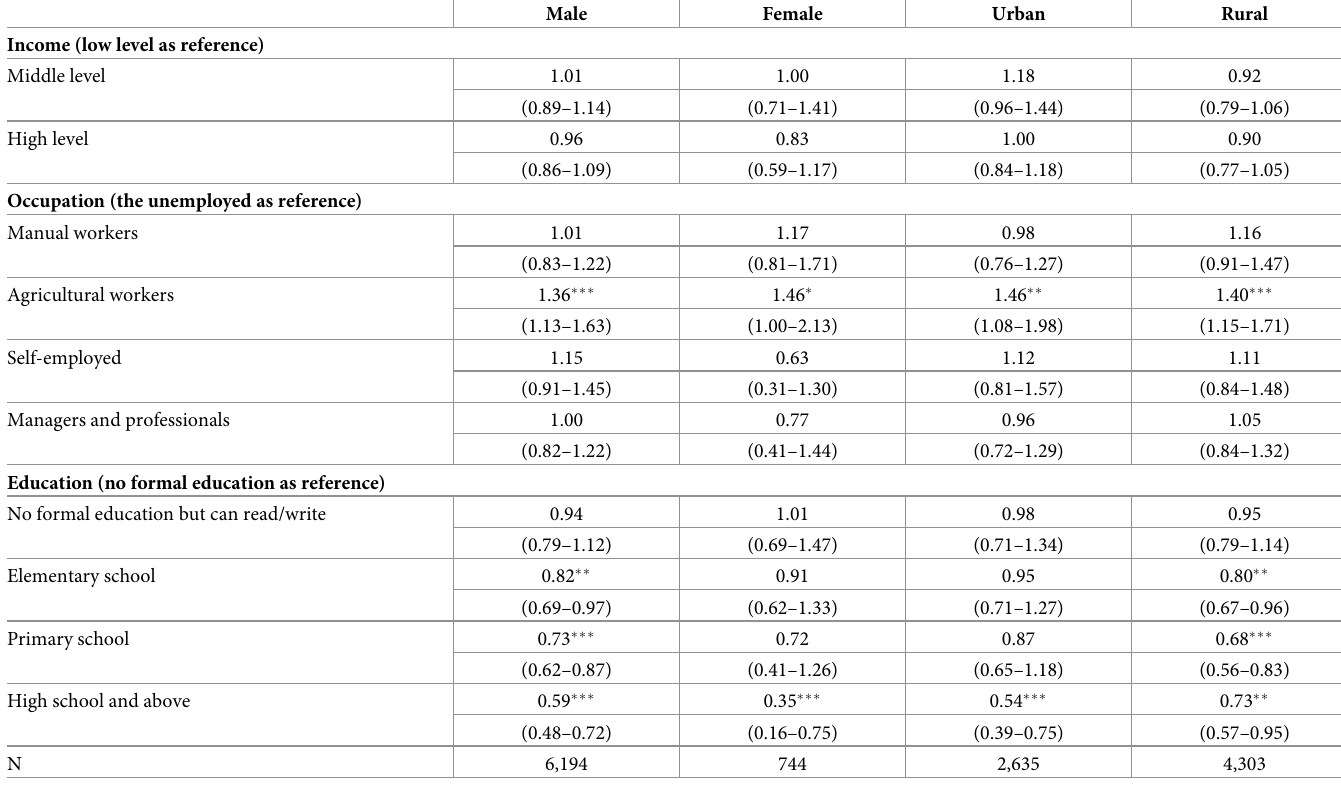
Table 5. Association between SES and Heaviness of smoking index using ordered Logit model: OR with 95%